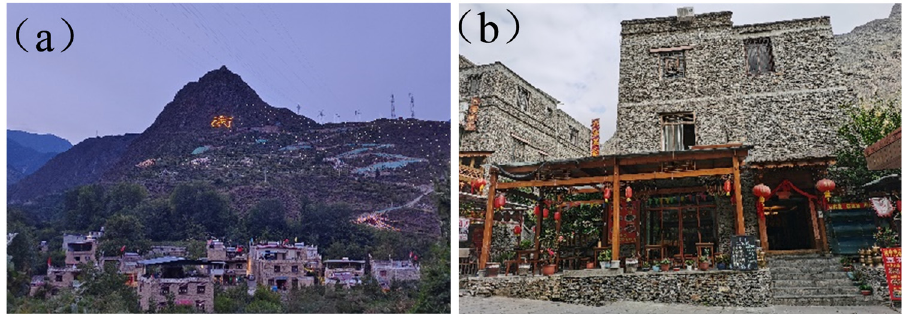
Figure 1: Tibetan and Qiang folk houses in western Sichuan: ( a ) Tibetan Village and ( b ) Qiang Village.